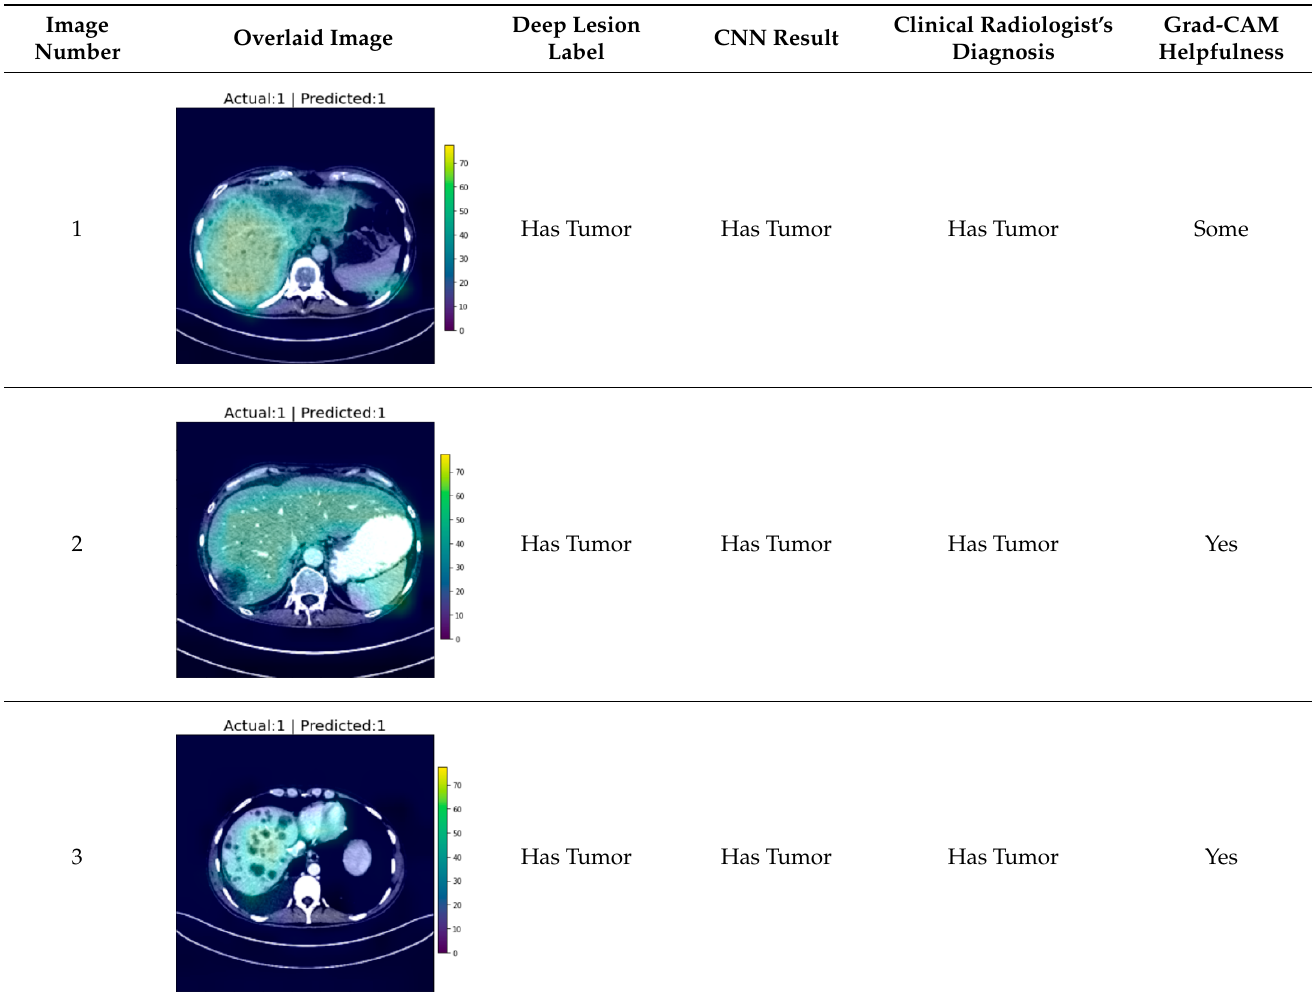
Table 3. Grad-CAM heat-map-overlaid CT images with respective labels and diagnoses. Image Overlaid Image Number